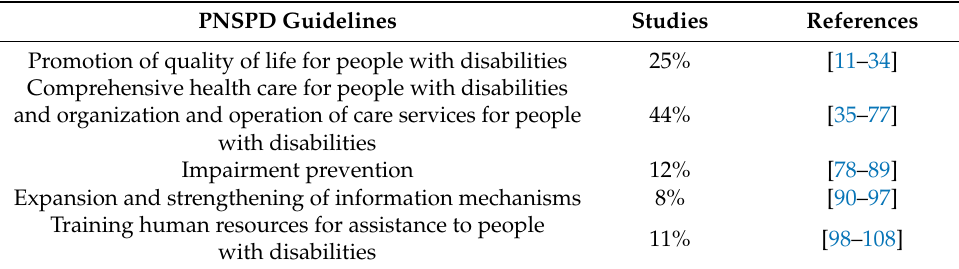
Table 2. Studies grouped according to PNSPD